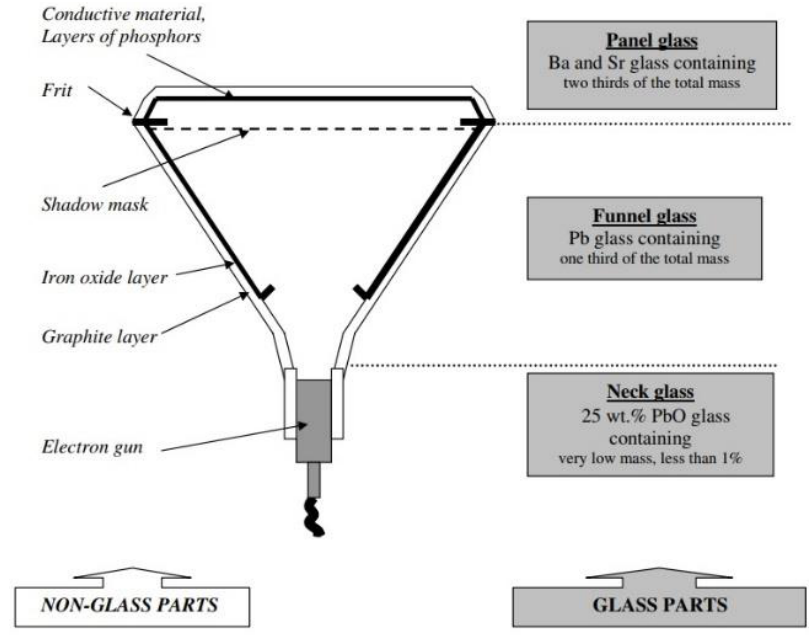
Figure 1. Appearance of cathode ray tube and its constituent parts [6].